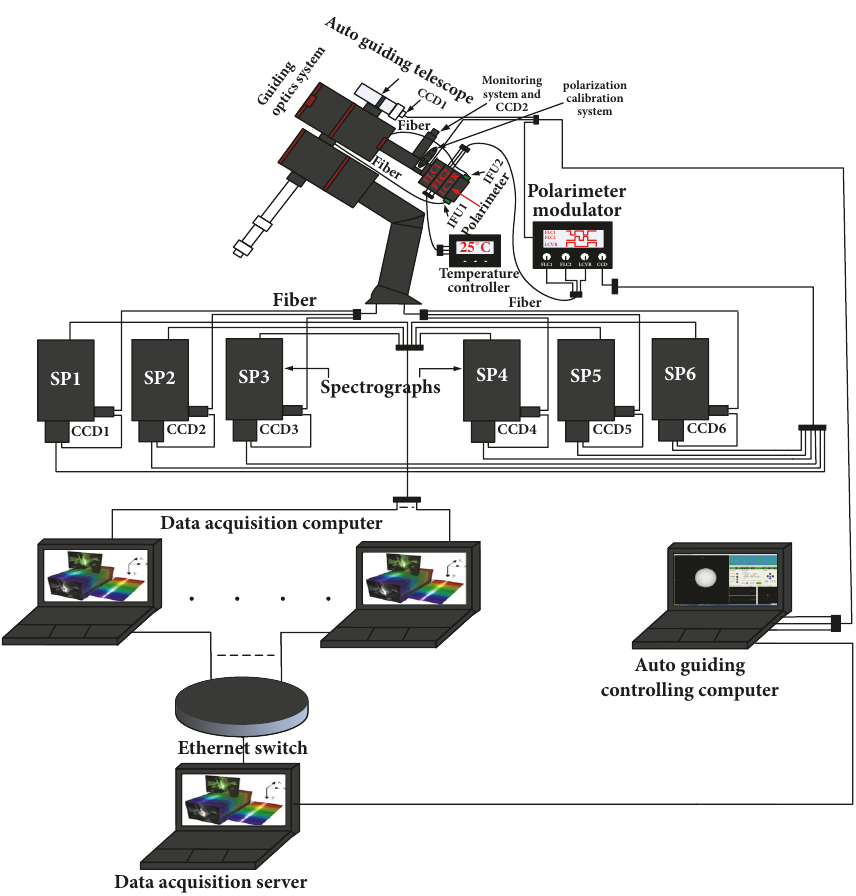
Figure 2: The structure diagram of controlling system of